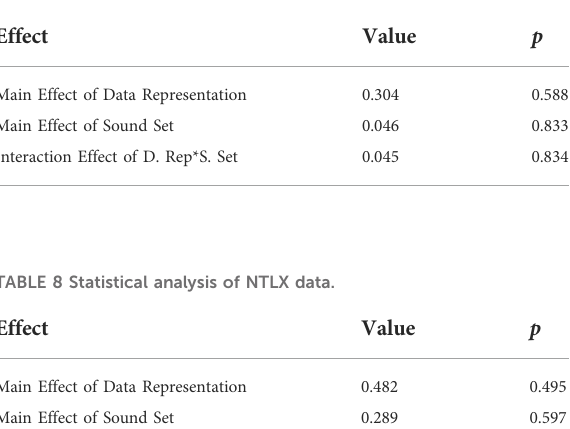
TABLE 7 Statistical analysis of SUS data.